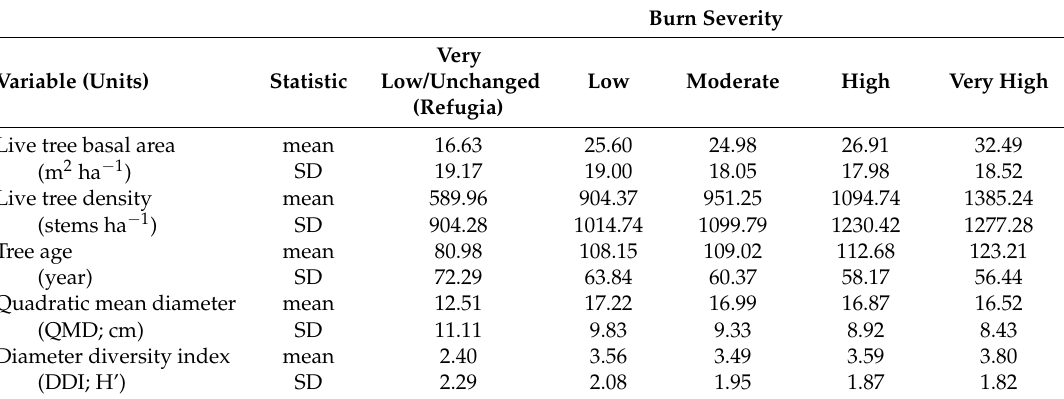
Table 5. GNN structure variables across study fires.